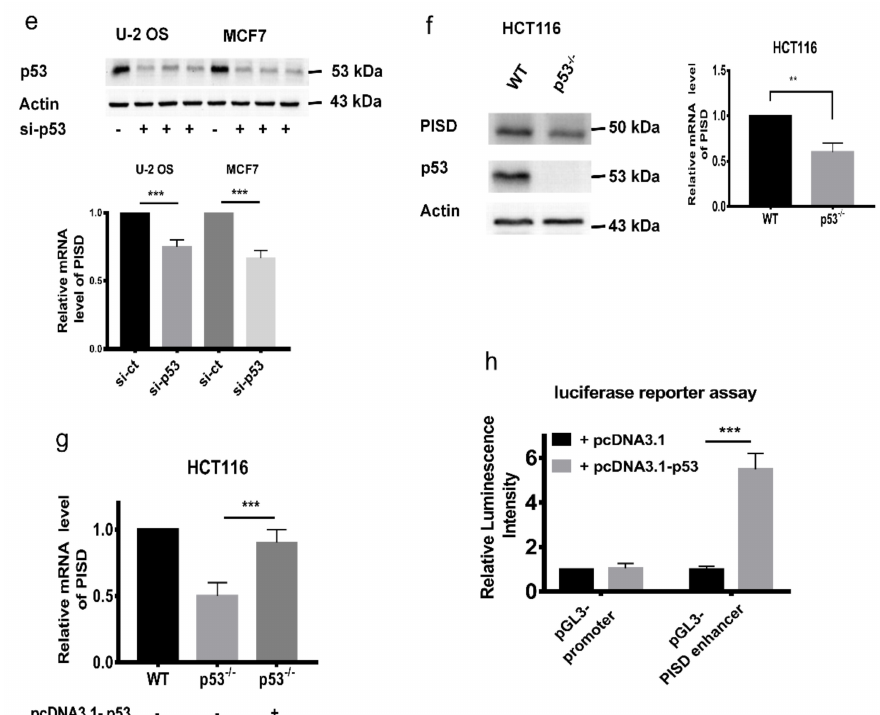
Figure 3. PISD expression is regulated by p53. ( a ) Western blotting analysis of protein levels of p53 in TFAM knockdown cells. ( b ) qRT-PCR analysis of p53 mRNA levels in sh-C or sh-TFAM transfected cells. ( c ) Protein stability analysis of p53 by detecting the residual levels of p53 at di ff erent time points after cycloheximide (CHX) (30 µ g / mL) treatment in TFAM knockdown cells. ( d ) The mRNA levels of PISD after treatment with 10 µ M pifithrin- α or 10 µ M nutlin-3 respectively for 3, 6, and 9 hours in MCF7 and U-2 OS cells. ( e ) The mRNA levels of PISD in MCF7 and U-2 OS cells after the expression